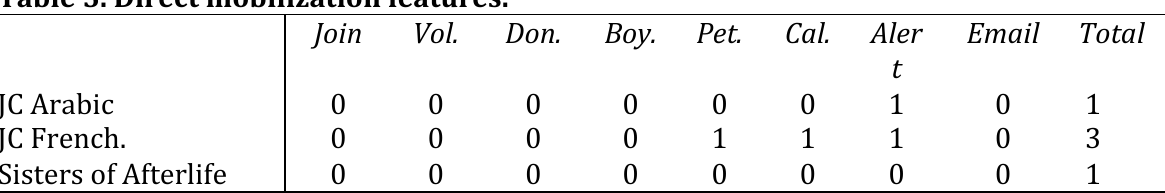
Table 5. Direct mobilization features. Join Vol. Don. Boy. Pet. Cal. Aler